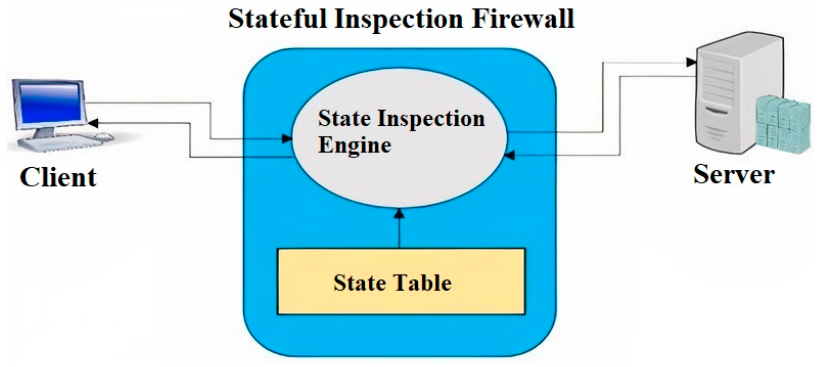
Figure 2. Stateful inspection firewall.